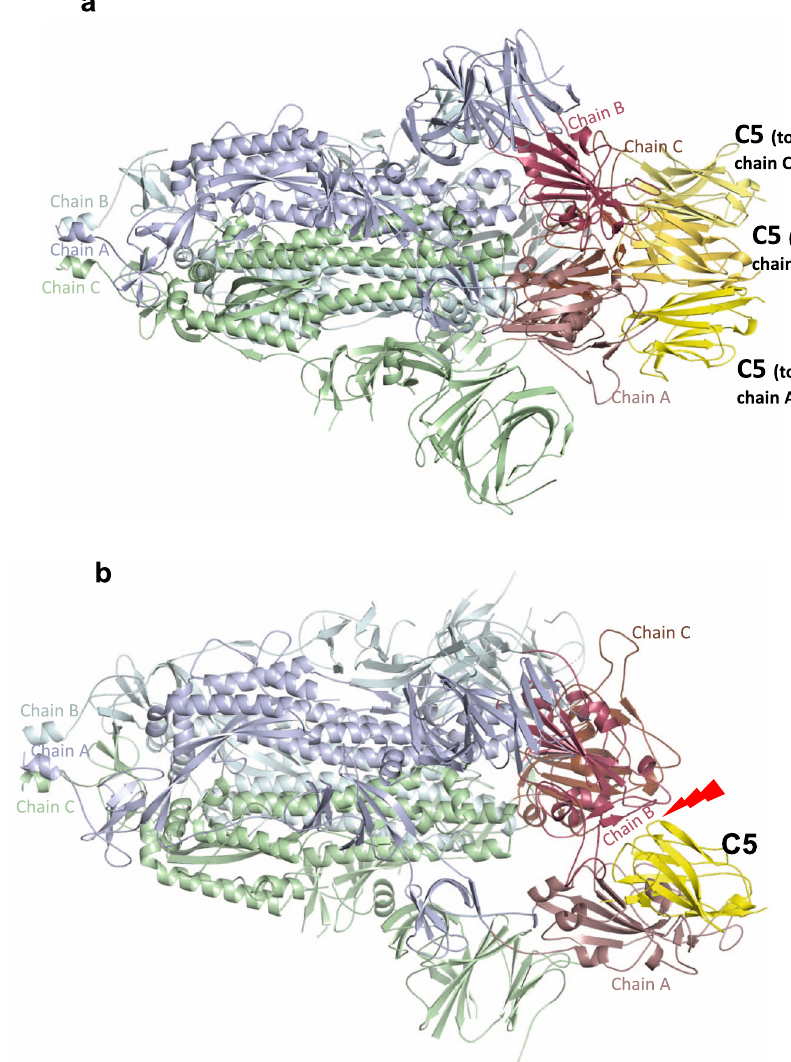
Fig. 4 Cryo-EM structure of C5-Spike complex. a EM structure of spike (S1) trimer with each of three chains bound to one C5 nanobody coloured yellow. The other spike monomers are coloured pale cyan, green and purple wheat and throughout and show that all three RDBs are in the down conformation. b Superimposition of C5 onto the spike protein in the two down one up conformation shows that there would be signi fi cant clashes that would prevent this